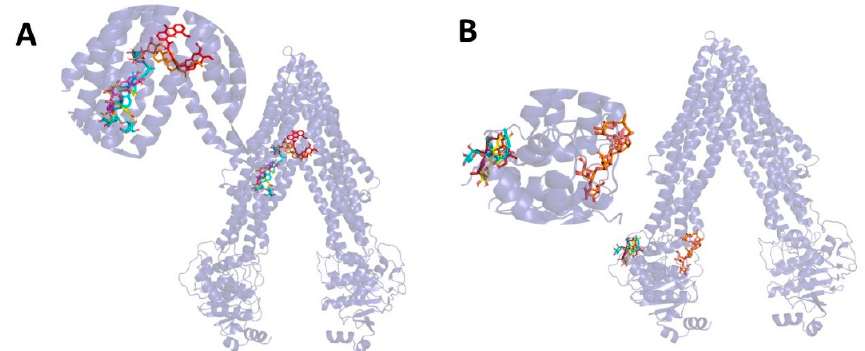
Figure 5. ( A ). P-gp showing inhibitor binding cavities and docked TAIII (orange), TBII (magenta), MGF (yellow), BHI (blue), and Elacridar (red). P-gp is shown in cartoon representation with slate purple. ( B ). P-gp showing nucleotide-binding domain and docked TAIII (orange), TBII (magenta), MGF (yellow), BHI (blue), and Verapamil (red). P-gp is shown in cartoon representation with slate purple. Table 4. Binding free energy and involved key residues for TAIII, TBII, MGF, BHI, elacridar, and verapamil in the predicted binding sites of P-gp.